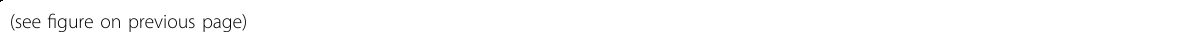
Fig. 2 Arzanol drives LC3-II accumulation independent of the AKT/mTOR-pathway. A Structure of arzanol. B – F Immunoblot analysis of mTOR/ ULK1-pathway proteins during serum- and amino acid starvation. Wild-type HeLa cells were starved in serum- and amino acid-free medium for 6 h while being incubated with baf A 1 or different concentrations of self-isolated arzanol. Data show quanti fi ed means of biological triplicates normalized to β -actin (ACTB) ± SEM. Representative immunoblots are additionally shown. Nonadjacent lanes (i.e., full medium control lane) are indicated by vertical black lines. Statistical analysis was performed using two-way ANOVA with Dunnett ’ s multiple comparison test comparing treated to untreated samples, *** P < 0.001, **** P < 0.0001. G Simpli fi ed pathway of key proteins of the mTOR/ULK1-axis in starvation-induced autophagy. H , I Immunoblot analysis of LC3-II and p62/SQSTM1 during serum-starvation. Wild-type HeLa cells were starved in serum-free (dark bars) or serum- and amino acid-free (light bars) medium for 6 h while being incubated with baf A 1 or different concentrations of commercially available arzanol. Data show quanti fi ed means of biological triplicates normalized to ACTB ± SEM. J HeLa cells stably expressing GFP-LC3-RFP-LC3 Δ G were starved in serum- and amino acid- free medium for 6 h while incubated with different concentrations of commercially available arzanol. Data show fold increase of GFP-LC3 fl uorescence relative to mock-treated control as means ± SEM of three biological